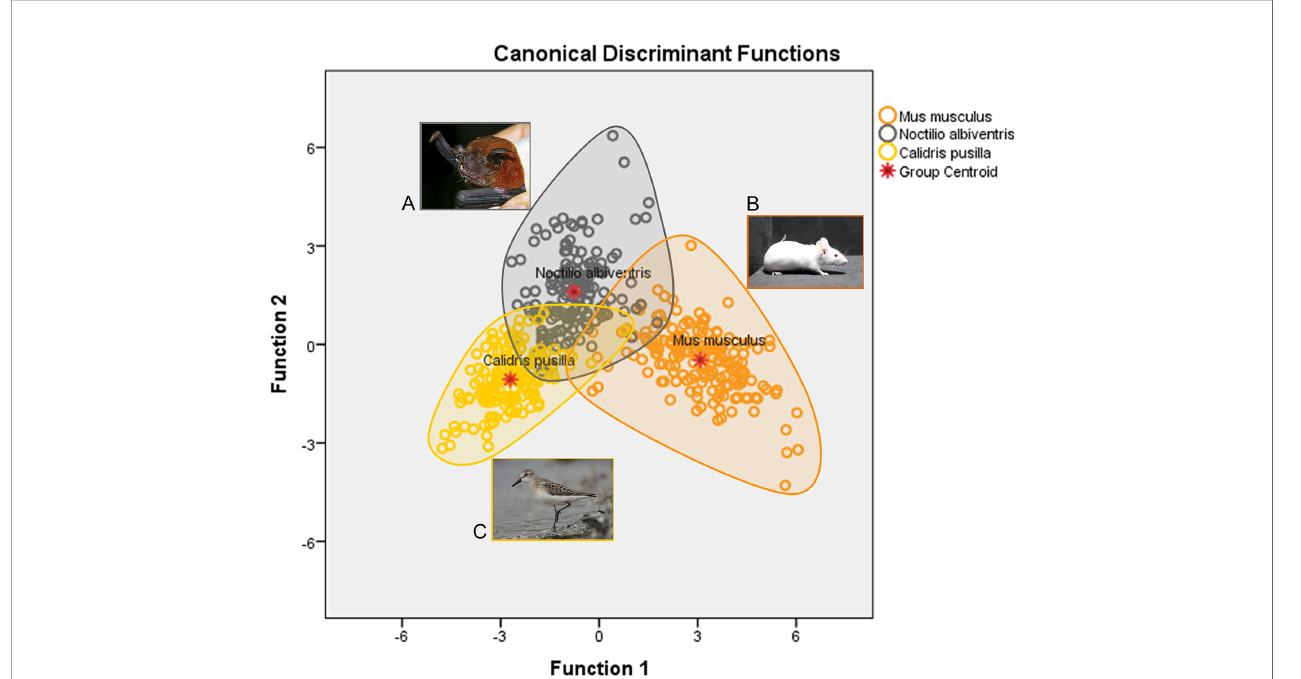
functions of all microglia morphological features of M. musculus , N. albiventris and C. pusilla . Three different ellipsoids, each one corresponding to a different species, occupy distinct regions of the Euclidian space. The ellipsoid representing the microglia of